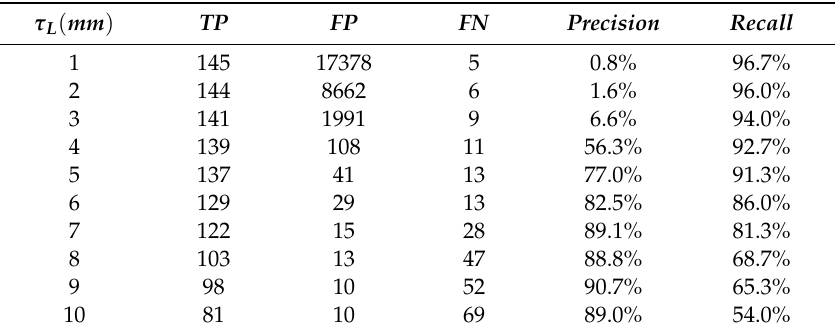
Table 2. Variation of precision and recall with the threshold τ L .